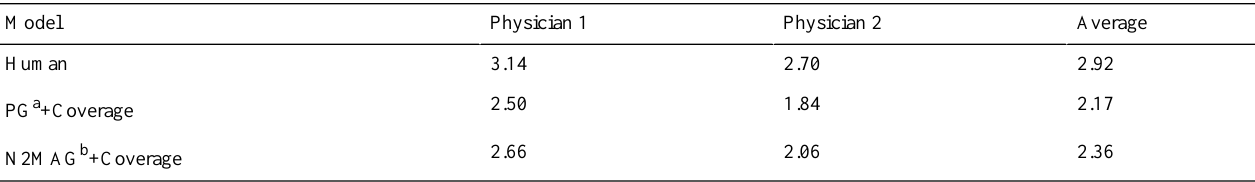
Table 2. Results of two